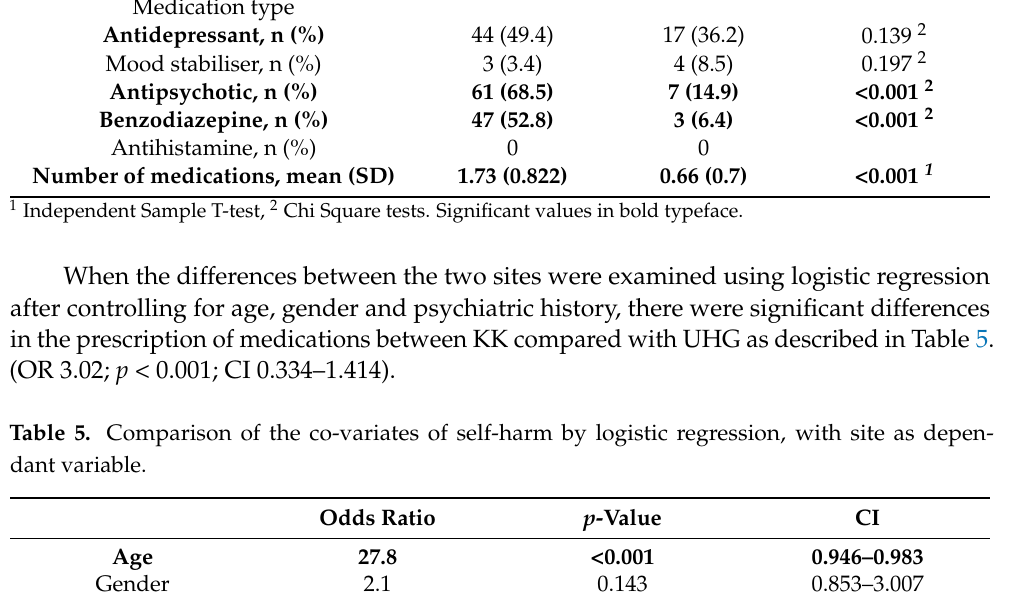
Table 4. The prescription of psychotropic medications at the two sites for patients admitted to a psychiatric unit. Kaunas Galway p -Value Medications, n (%)